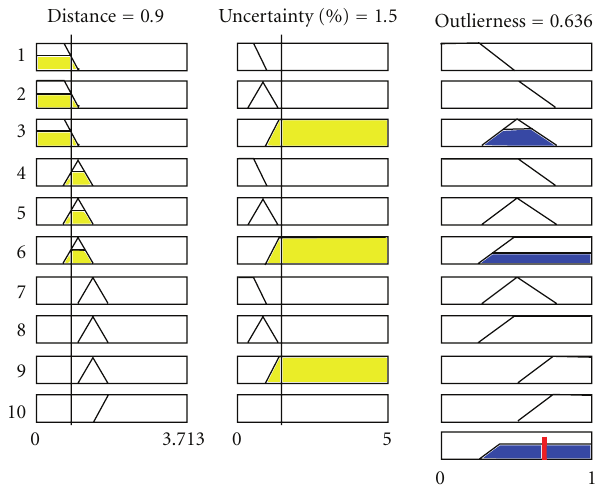
Figure 3: Application of the fuzzy inference system to the candidate outlier x = 25 . 9.